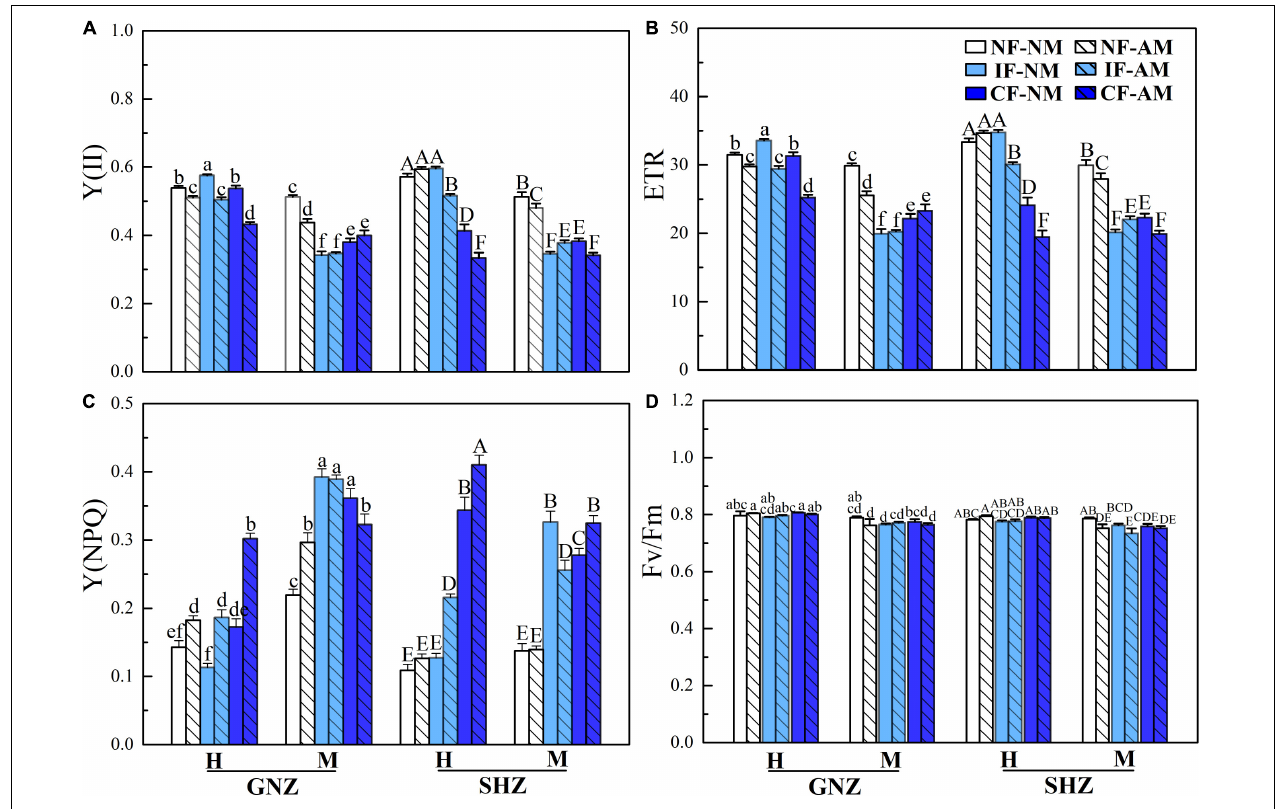
FIGURE 2 | Rice chlorophyll II fluorescence parameters under non-flooding (NF), intermittent flooding (IF), and continuous flooding (CF) conditions in Exp. 1. (A) Actual quantum yield [Y(II)], (B) the electron transport rate (ETR), (C) the yield of non-photochemical quenching [Y(NPQ)], and (D) the maximum quantum yield (Fv/Fm) in the mycorrhizal (AM) and non-mycorrhizal (NM) leaves of Guinongzhan (GNZ) and Sanhuangzhan (SHZ) collected at heading (H) and maturing (M) harvest stages. Lowercase letters are used in GNZ cultivar analysis, and uppercase letters are used in SHZ cultivar analysis. Different letters above the columns indicate significant differences at the P < 0.05 level. Means and standard errors from three replicates are shown.